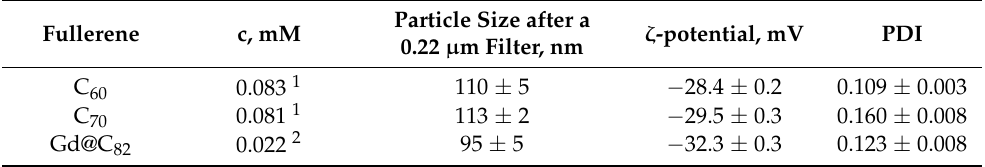
Table 1. Concentrations ( c ), size, zeta-potentials ( ζ ), and polydispersity indices (PDI) of the AFDs. Fullerene c,